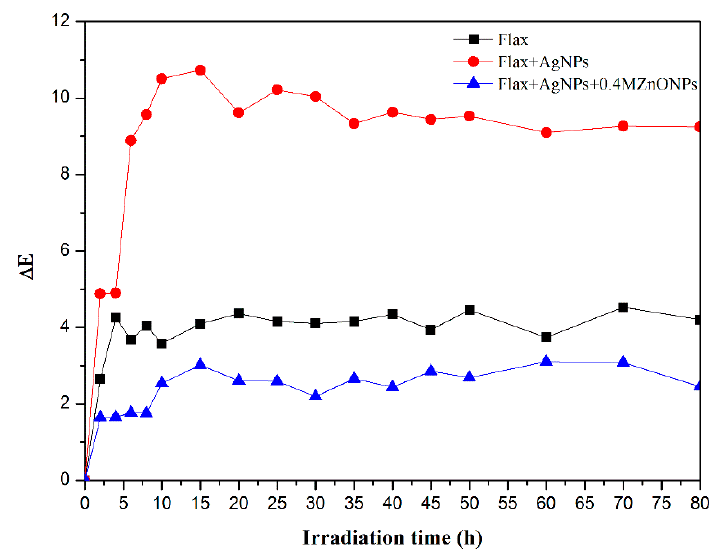
Figure 11. Total colour change with irradiation time of flax fabrics (black curve) flax fabrics coated with AgNPs(red curve) and with Ag/ZnO NPs (blue curve).